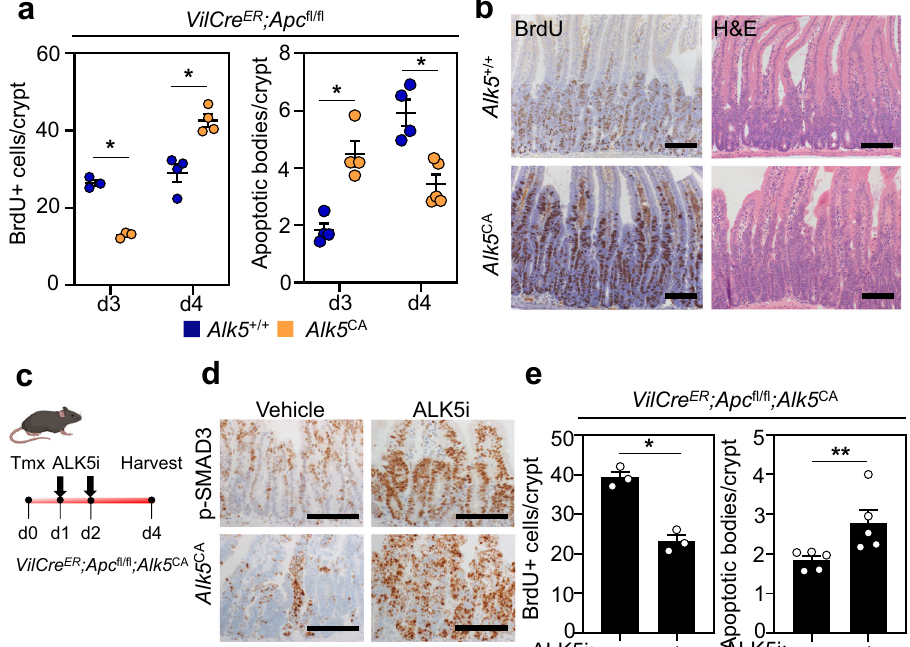
Fig. 3 | Apc-mutant cells are sensitive to cell-intrinsic TGF β signalling. a Quanti fi cationofBrdU-positive(left)andapoptoticcells(right)in VilCre ER ;Apc fl / fl ;Alk5 +/+ (blue) and VilCre ER ;Apc fl / fl ;Alk5 CA (orange) small intestinal crypts 3 and 4 days post- tamoxifen induction. n =4 mice per group, except n =3 mice per group for d3 BrdU data. Data were ±s.e.m; * P =0.05, one-tail Mann – Whitney U -test. b Representative BrdU and H&E staining of small intestinal tissue from VilCre ER ;Apc fl / fl ;Alk5 +/+ and Vil- Cre ER ;Apc fl / fl ;Alk5 CA mice4dayspost-tamoxifeninduction.Scalebar,100 μ m. c Schematic illustrating the treatment timeline and tissue analysis from VilCre ER ;Apc fl / fl ;Alk5 CA mice.